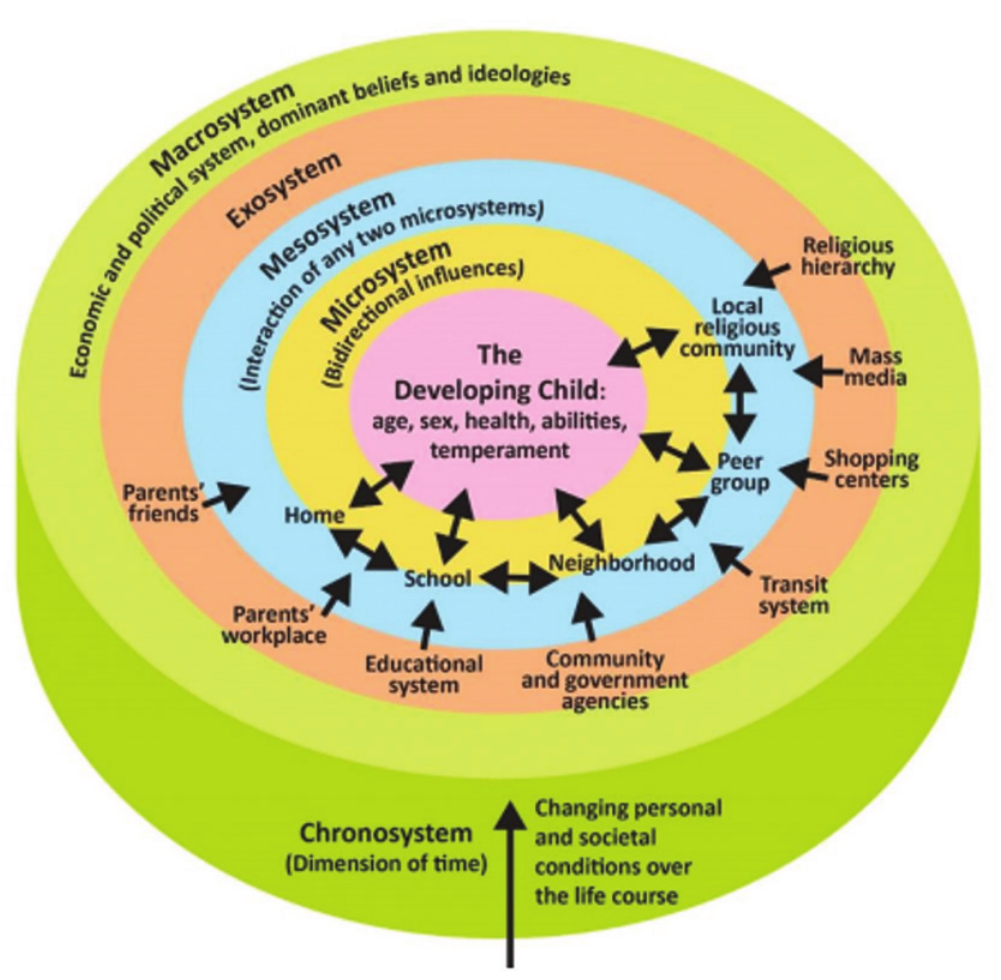
Figure 1: The learning ecology model of Brofenbrenner (1979), adapted by Ian Joslin (from Laff and Ruiz,